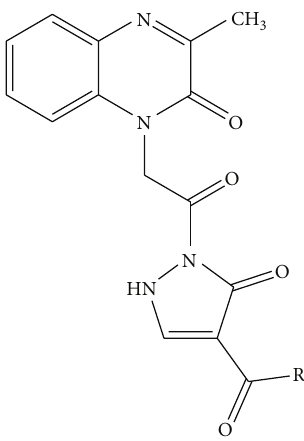
Figure 7: Chemical structures of compounds tested.